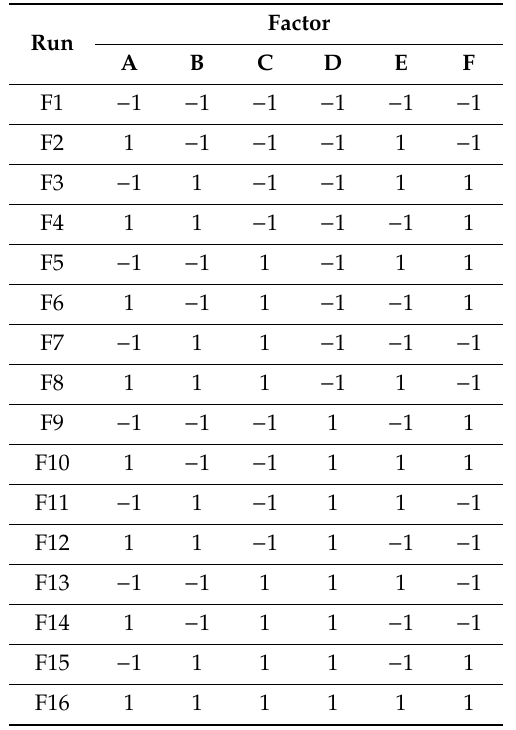
Table 4. FFD matrix for six variables with coded values for the growth enhancement, cellulolytic and hemicellulolytic enzyme productions of Lactobacillus plantarum RI